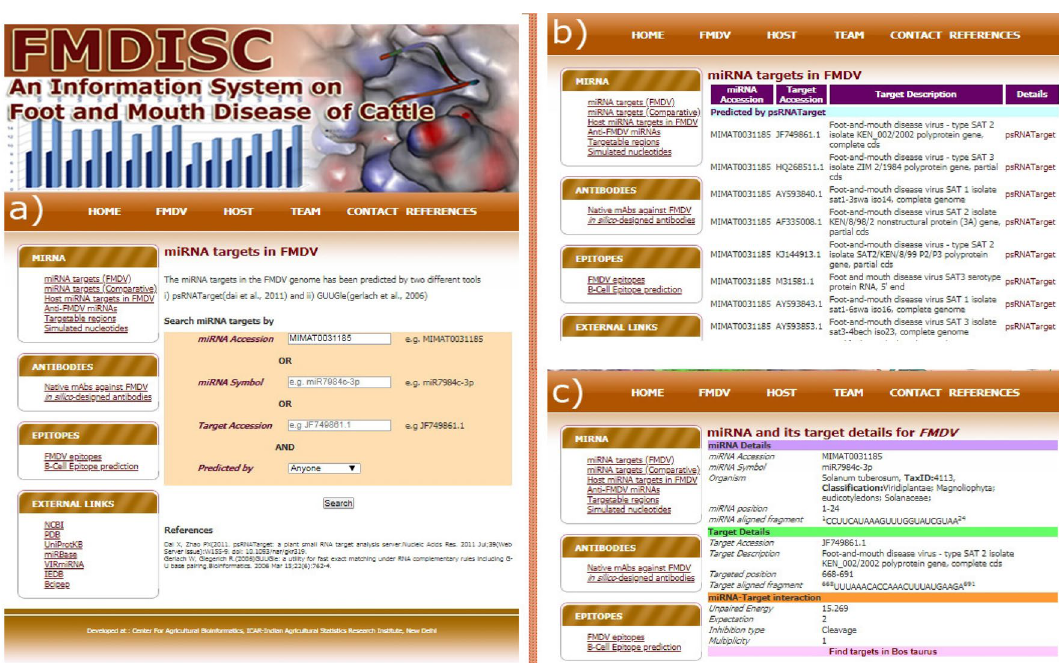
Figure 3. Interface for miRNA target search in FMDV showing ( a ) search interface, ( b ) listing of miRNAs based on search parameters and ( c ) miRNA and its target